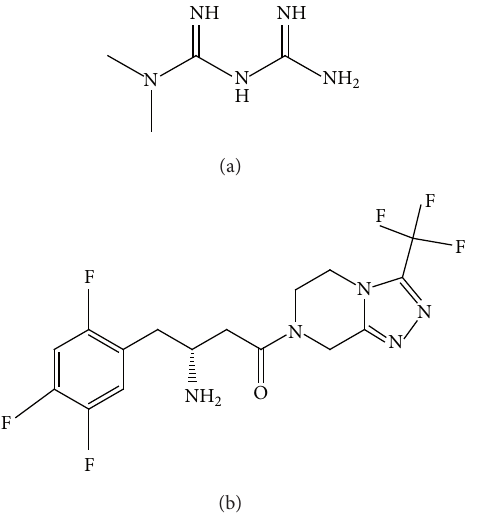
F 1: Structural formula for MET (a) and SITA (b).